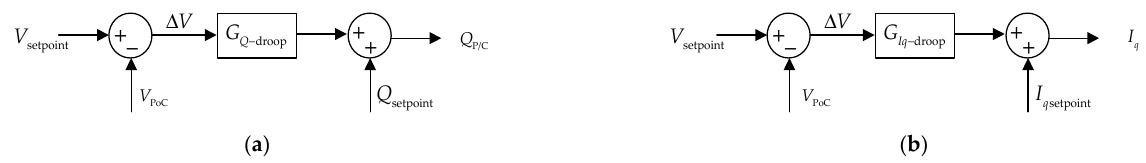
Figure 4. Proportional control based reactive power control strategy at smart converter: ( a ) Voltage Q–droop control; ( b ) Voltage I q − droop control.